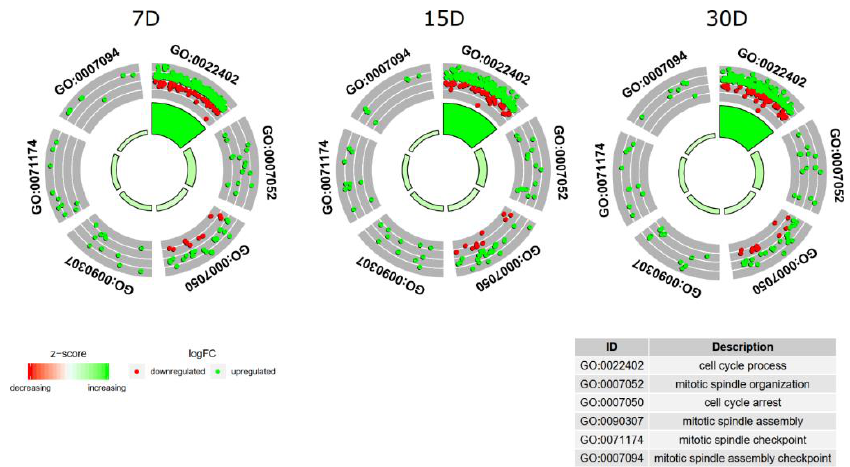
Figure 2. A circular visualization of the results of the gene annotation enrichment analysis. The outer circle shows a scatterplot for each term of the fold change logarithm (logFC) of the assigned genes. Green circles display upregulation, and red ones display downregulation. The inner circle is the representation of the z -score. The size and the color of the bar correspond to the value of the z -score. D-days of culture.